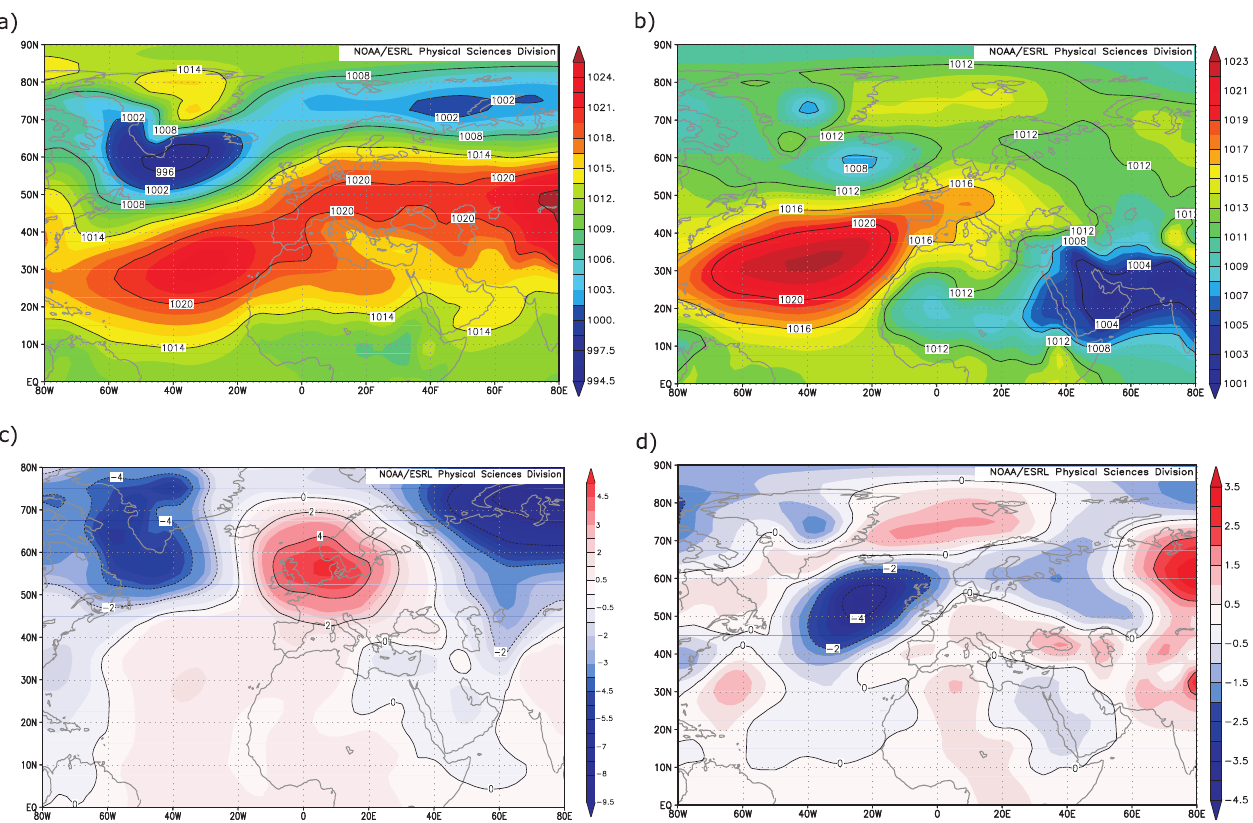
Fig. 9. Spatial distribution of sea level pressure (SLP) for 2003 (a) JFM period (b) MJJA period and SLP anomalies relative to 1968–1996 for (c) JFM period and (b) MJJA period Images were provided by the NOAA-CIRES (taken from Climate Diagnostics branch, Boulder, Colorado